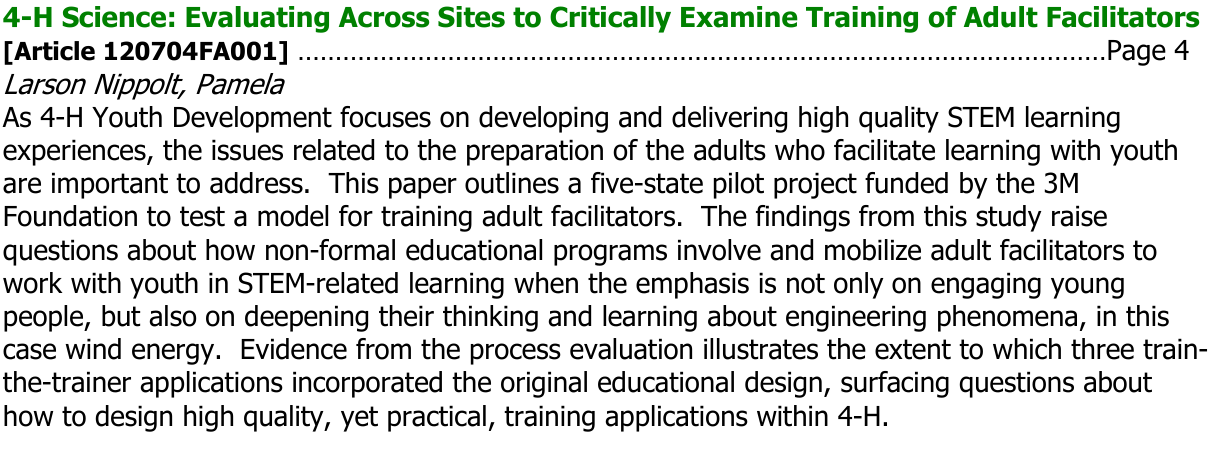
4-H Science: Evaluating Across Sites to Critically Examine Training of Adult Facilitators Larson Nippolt,